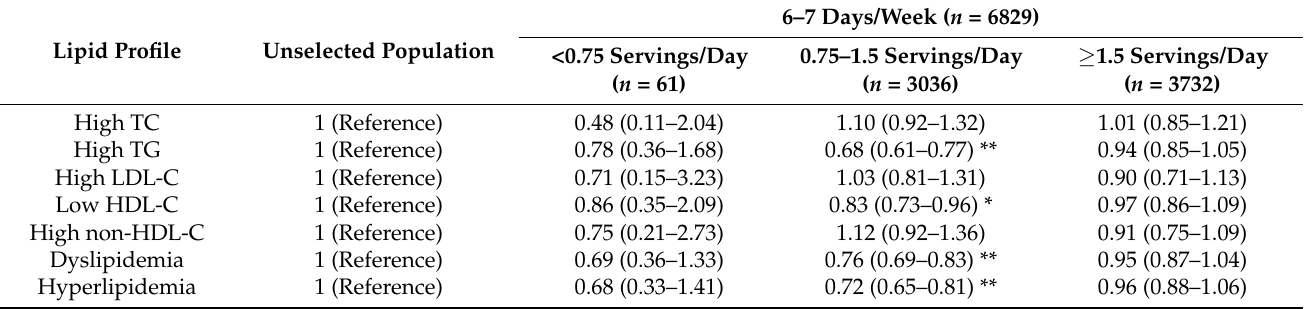
Table 3. Combined effects of frequencies and daily intake of fruit consumption on adverse lipid profile ( n =